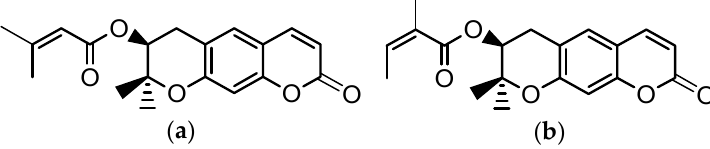
Figure 1. Chemical structures of: ( a ) decursin (D) and ( b ) decursinol angelate (DA).